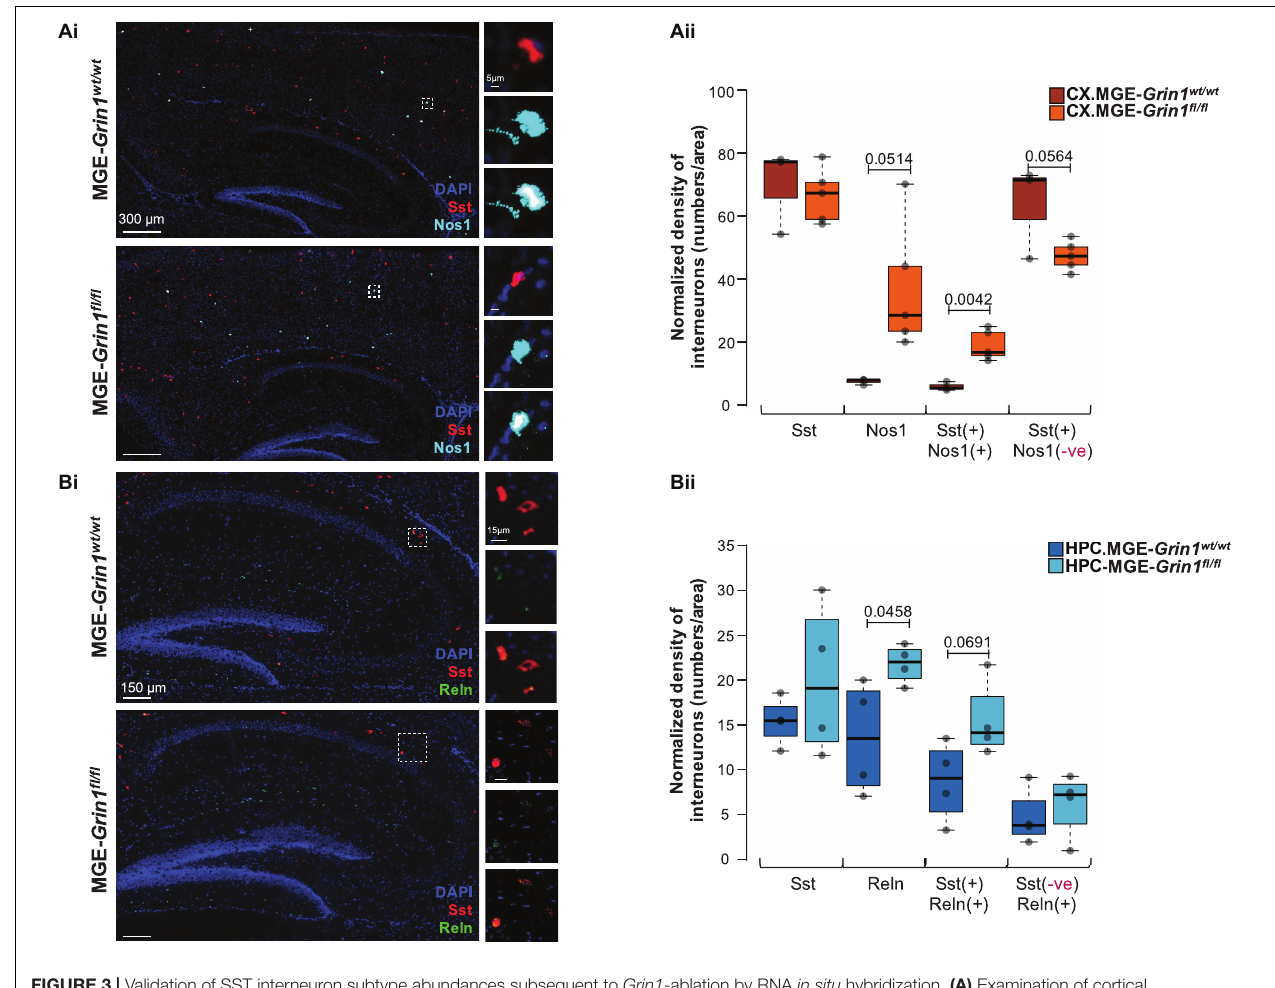
FIGURE 3 | Validation of SST interneuron subtype abundances subsequent to Grin1 -ablation by RNA in situ hybridization. (A) Examination of cortical Nos1 -expressing Chodl -SST.1 subtype abundances by (Ai) in situ hybridization using Sst and Nos1 RNAscope probes from P20-25 somatosensory cortex, counterstained with DAPI. (Aii) Boxplots indicate Sst (+), Nos1 (+), Sst (+): Nos1 (+) or Sst (+): Nos1 (–) cell counts. (B) Examination of hippocampal Reln -expressing SST.2-4 subtype abundances by (Bi) in situ hybridization using Sst and Reln RNAscope probes from P20-25 hippocampus, counterstained with DAPI. (Bii) Boxplots indicate Sst (+), Reln (+), Sst (+): Reln (+) or Sst (–): Reln (+) cell counts. n = 4–6 brains from each genotype for immunostaining; n = 2 brains (4–6 sections/brain) from each genotype for RNAscope. Error bars reflect SEM; two-tailed unpaired t -test, for statistical